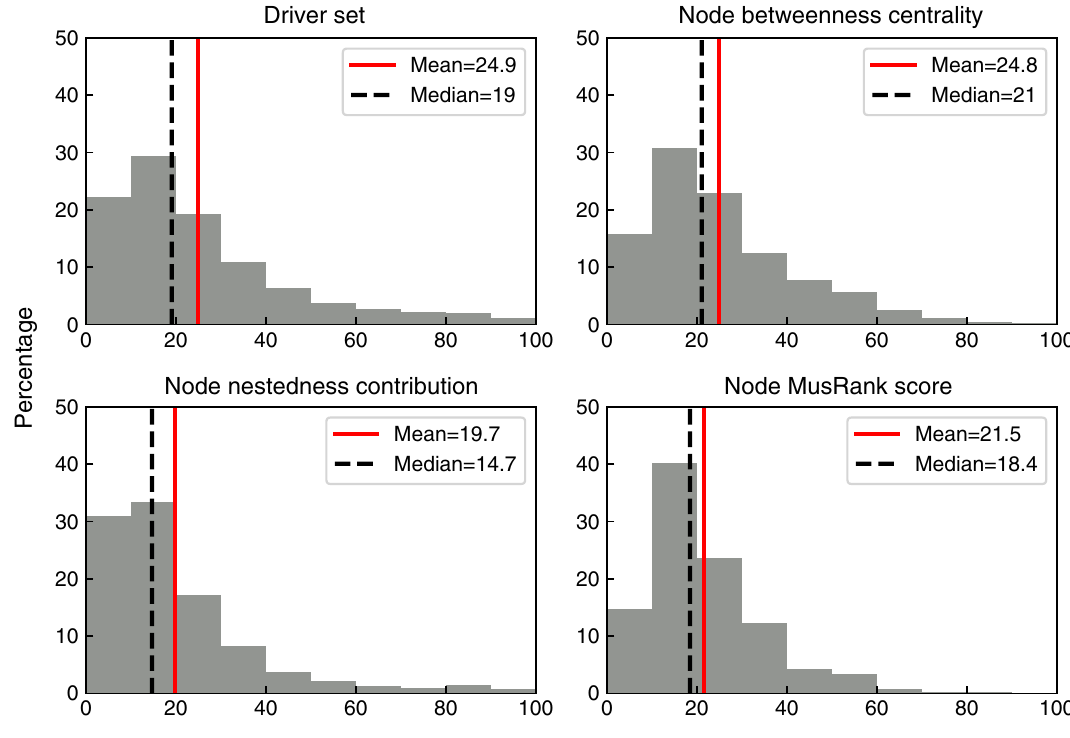
Figure 7. Histogram plots illustrating the performance of driver set analysis versus structural measures in identifying keystone species. The analysis was done on 6000 networks with sizes of 50–70 nodes. The starting point is the maximal richness community, i.e., the attractor in which the most species establish. For each network 1, 2, and 3 node(s) were selected and simultaneously fixed to their inactive states. After the cascading damage the new attractor is compared to the maximal richness attractor to calculate the damage percentage. The structural measures—betweenness centrality, node nestedness contribution, and node MusRank score—were calculated for all nodes in each network; the top 10% according to the relevant ordering were candidates to being fixed to their inactive states. The network IDs were matched, i.e., only the networks that had candidate nodes according to all four measures for each extinction size are included in this plot. The total number of data points is 6360. The red solid lines represent the mean and the black dashed lines represent the median over all data points in each